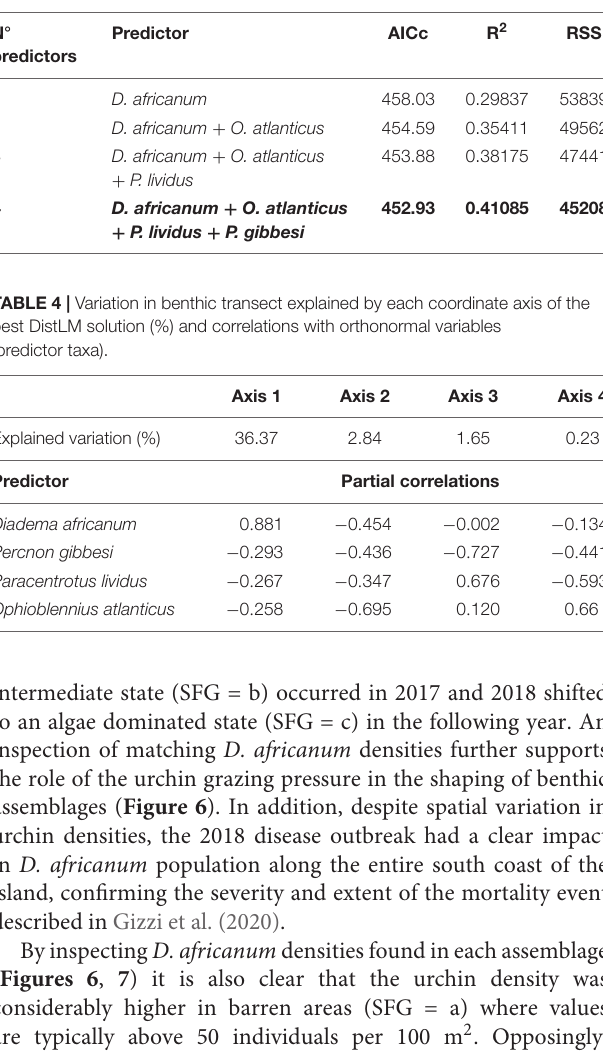
TABLE 3 | DistLM top solutions predicting Bray-Curtis similarities between benthic transect samples ( n = 68) with herbivore and grazer taxa densities as predictors (overall best solution in bold; AICc, Akaike information criterion; RSS, R Sum of Squares).